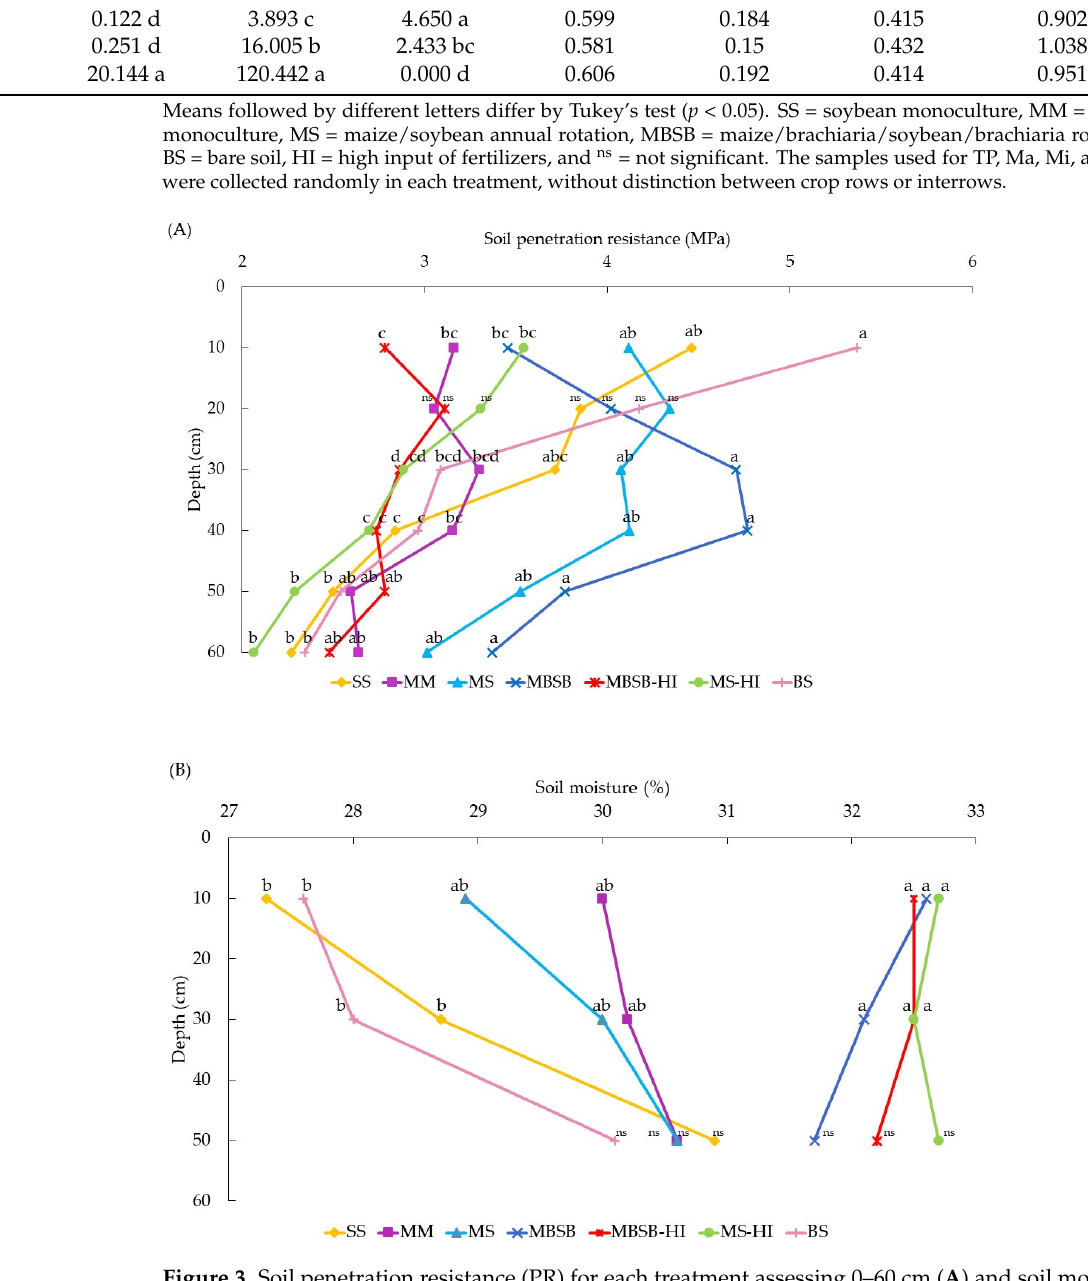
Figure 3. Soil penetration resistance (PR) for each treatment assessing 0–60 cm ( A ) and soil moisture ( B ) for three different depths (0–20 cm, 20–40 cm, and 40–60 cm) at the time of evaluation of soil penetration resistance. Means followed by different letters among treatments differ by Tukey’s test ( p < 0.05). SS = soybean monoculture, MM = maize monoculture, MS = maize/soybean annual rota- tion, MBSB = maize/brachiaria/soybean/brachiaria rotation, BS = bare soil, HI = high input of ferti-